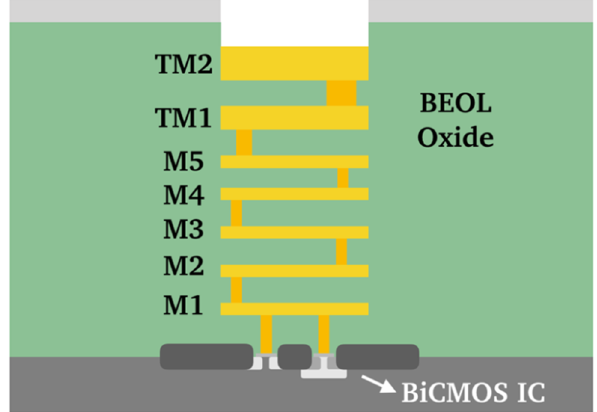
Figure 6. Cross section of the back-end-of-line (BEOL) in the SG13G2 0.13 µm SiGe:C BiCMOS